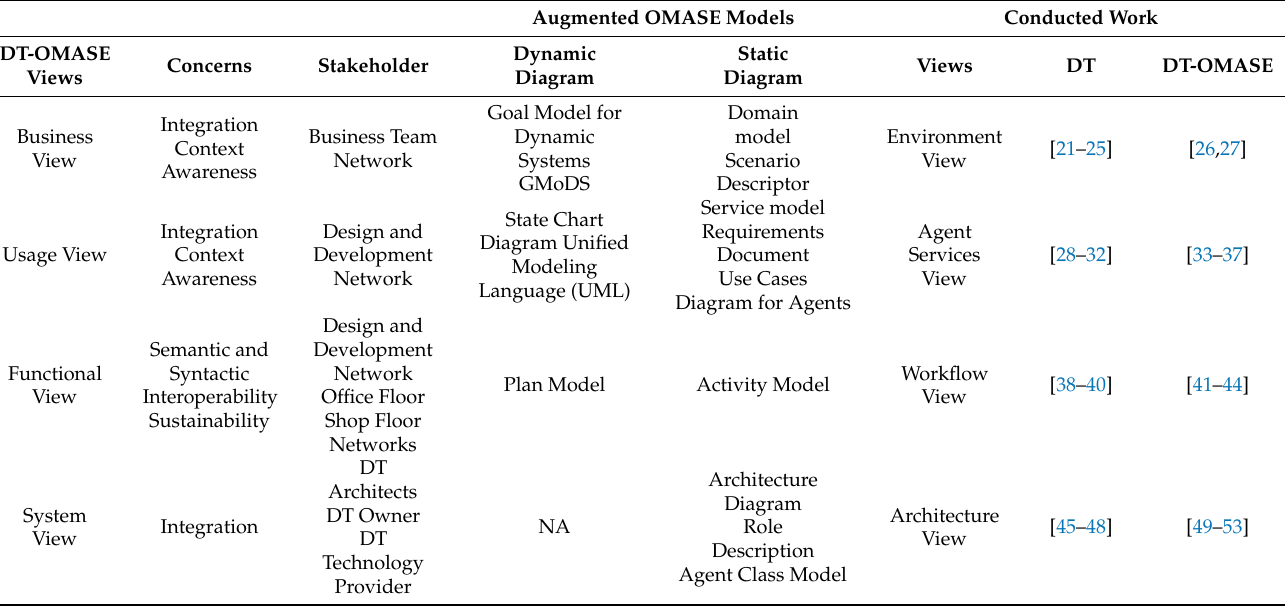
Table 1. DT-OMASE proposed views mapping to OMASE